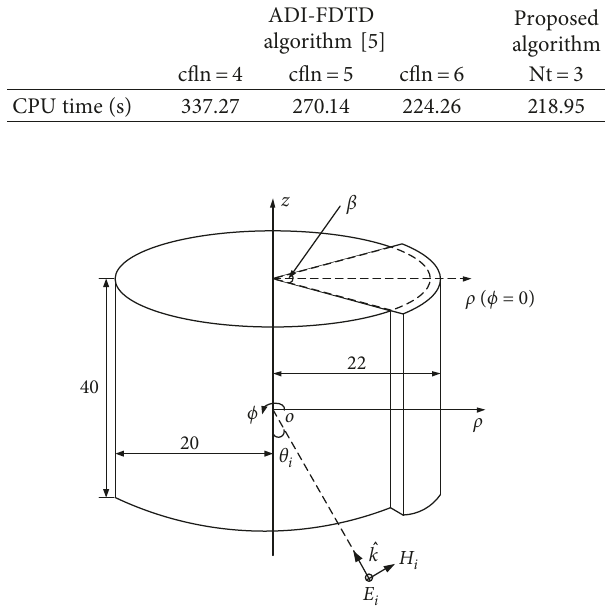
Figure 11: Illustration of the irregular cylinder with one wedge- shaped bulge under the oblique incident